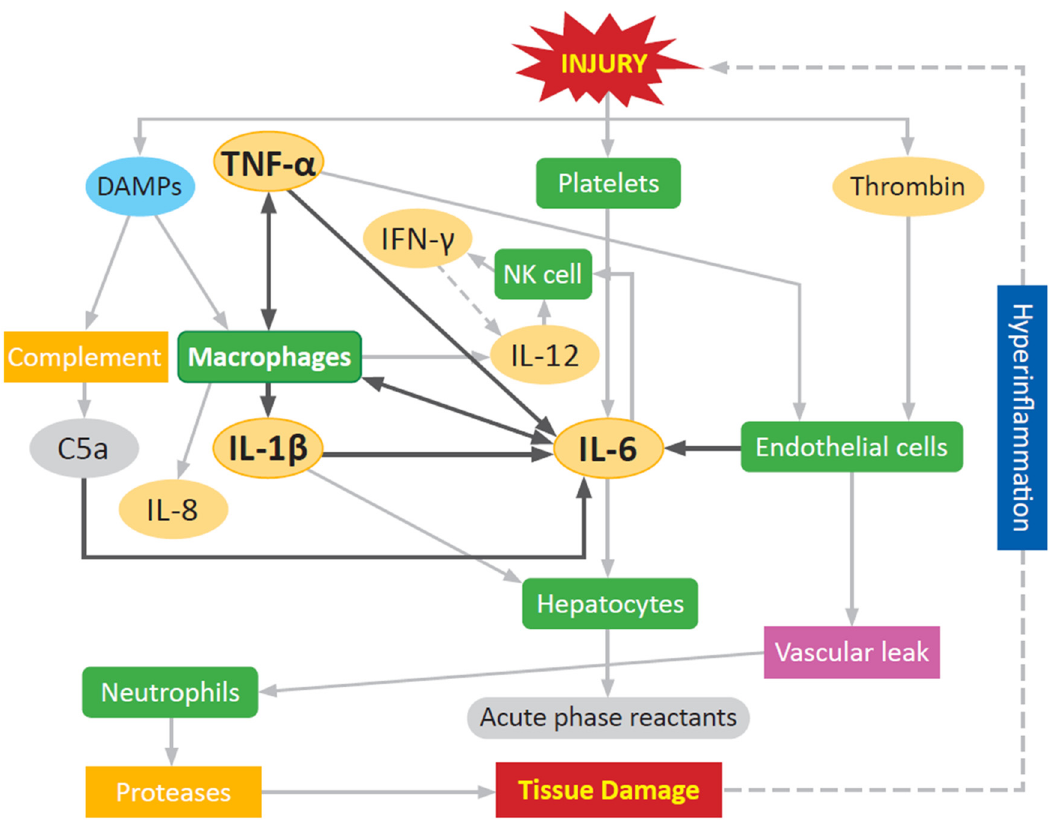
Figure 3. Inflammatory cytokines and the self-propagating trauma cycle. This diagram is a simplified representation of the complex web of pro-inflammatory cytokines and how continued activation leads to further tissue damage. The release of damage associated molecular patterns (DAMPs), platelets, and thrombin in response to injury activates macrophages and endothelial cells to mount a response. Cytokines, including interleukins (IL), and tumor necrosis factor (TNF)- α are key early messengers in the inflammatory response, acting to activate natural killer (NK) cells, macrophages, neutrophils, and hepatocytes. Hyperinflammation from an unrestrained response further contributes to tissue damage, engaging the inflammatory response again.